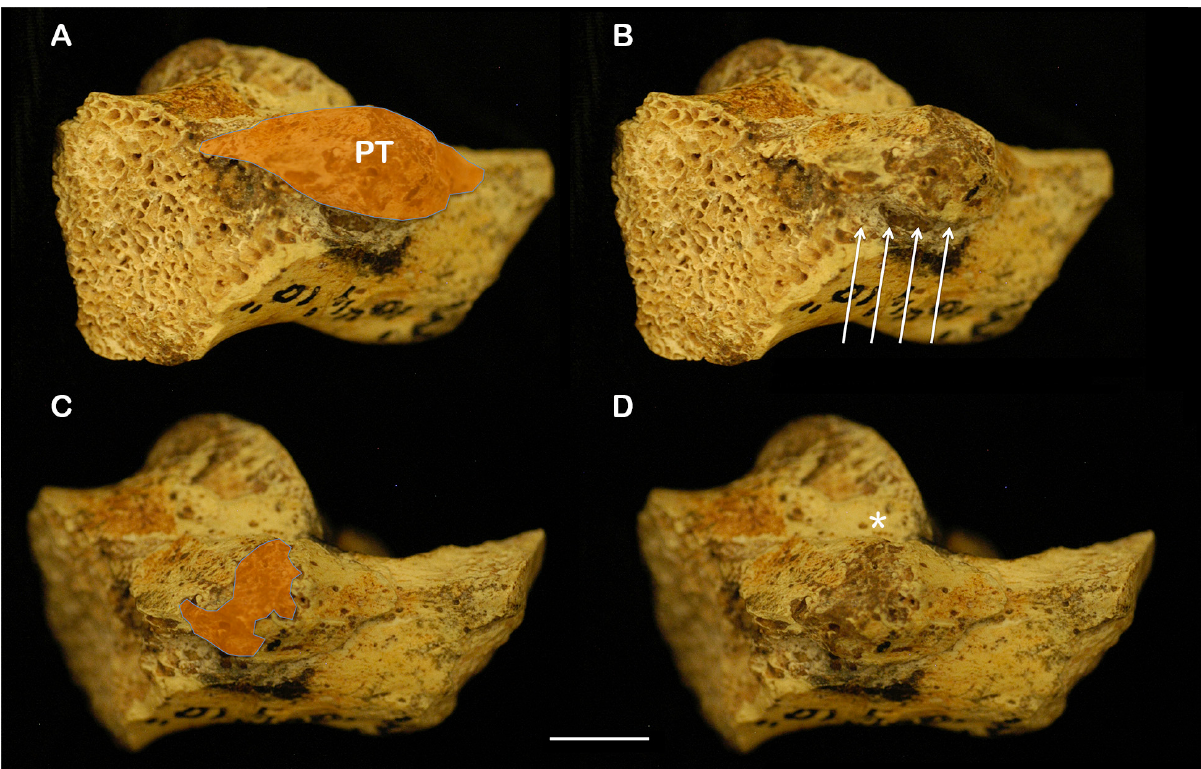
Figure 2: (A and B) Proximolateral views of StW 352. (A) Image highlighting the location of the peroneal trochlea (PT). (B) Arrows indicate the presence of a gap between the PT and the body of the calcaneus, which suggests that the true position of the PT should be more proximal and plantar than the current reconstructed position. (C and D) Lateral views of StW 352. (C) Highlighted outline of matrix infill. Notice how the proximal edge (to the left) may align fairly well with the dorsal edge (to the right), suggesting that these edges may refit if the intervening matrix was removed. (D) Unobstructed view of the splitting and expansion (underneath the star) of the middle of the PT caused by matrix. MicroCT scanning parameters for StW 352 and the compa rative calcanei Scanning Specimen number Species